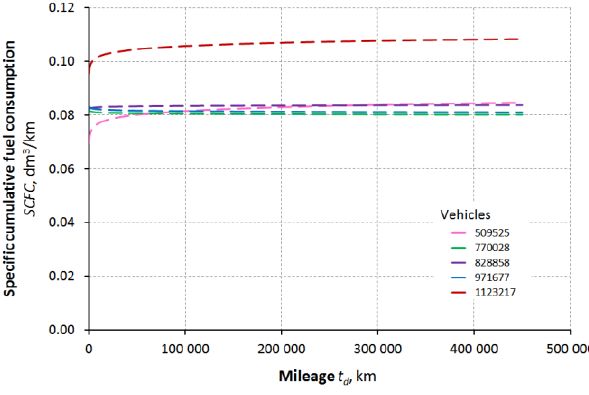
Fig. 7. Specific cumulative fuel consumption of analysed